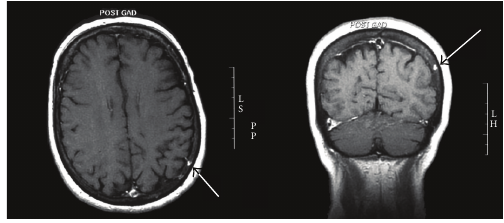
Figure 1: Radiology features of the lytic